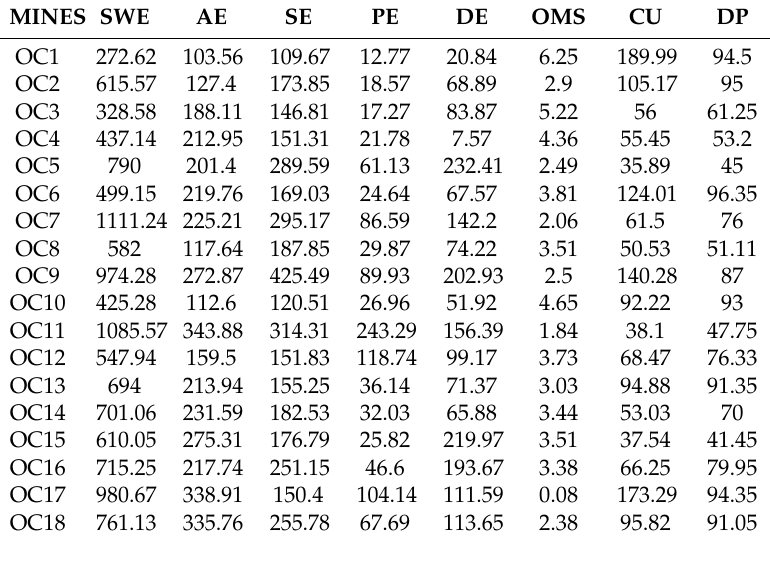
Table A3. Opencast Mines Data for